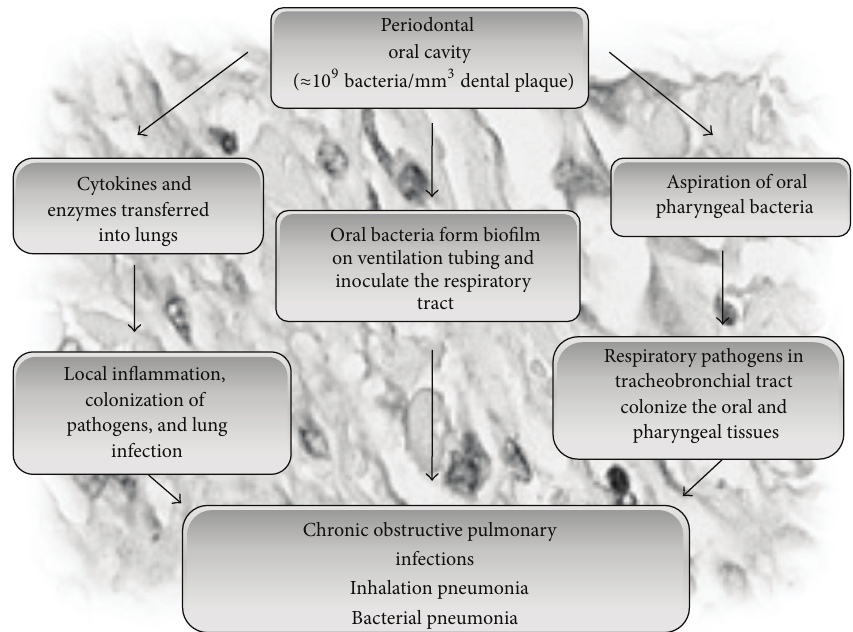
Figure 4: Possible role of periodontal infection in respiratory